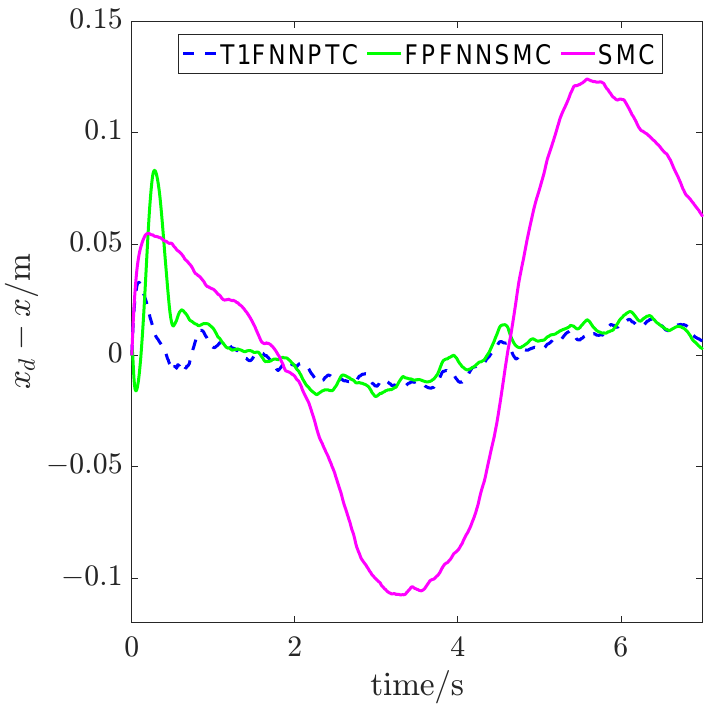
Figure 7. Tracking error of X